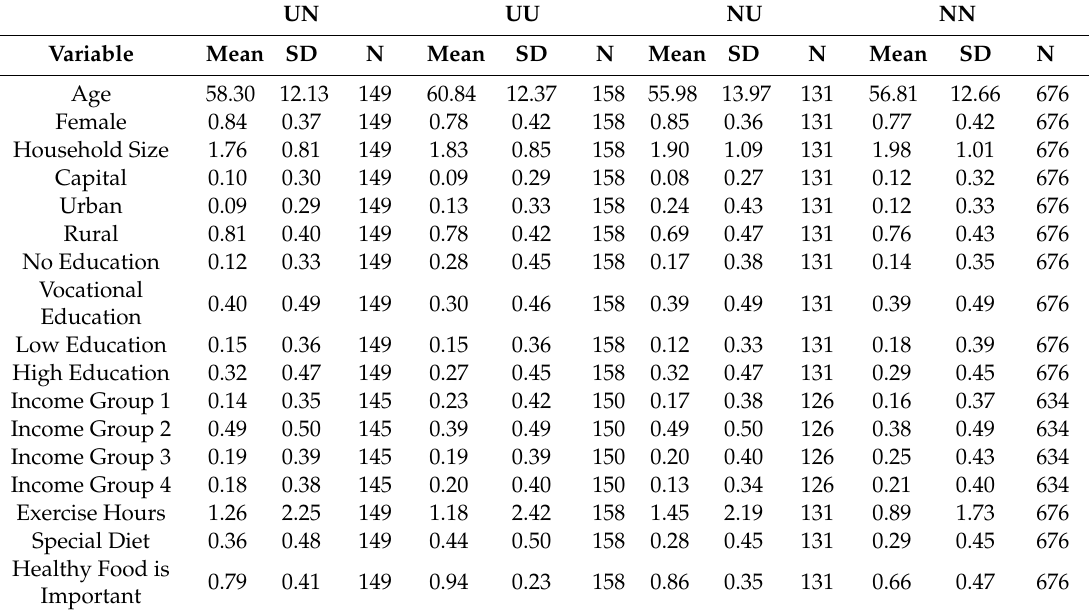
Table A1. Summary statistics for NL subgroups in 2013.